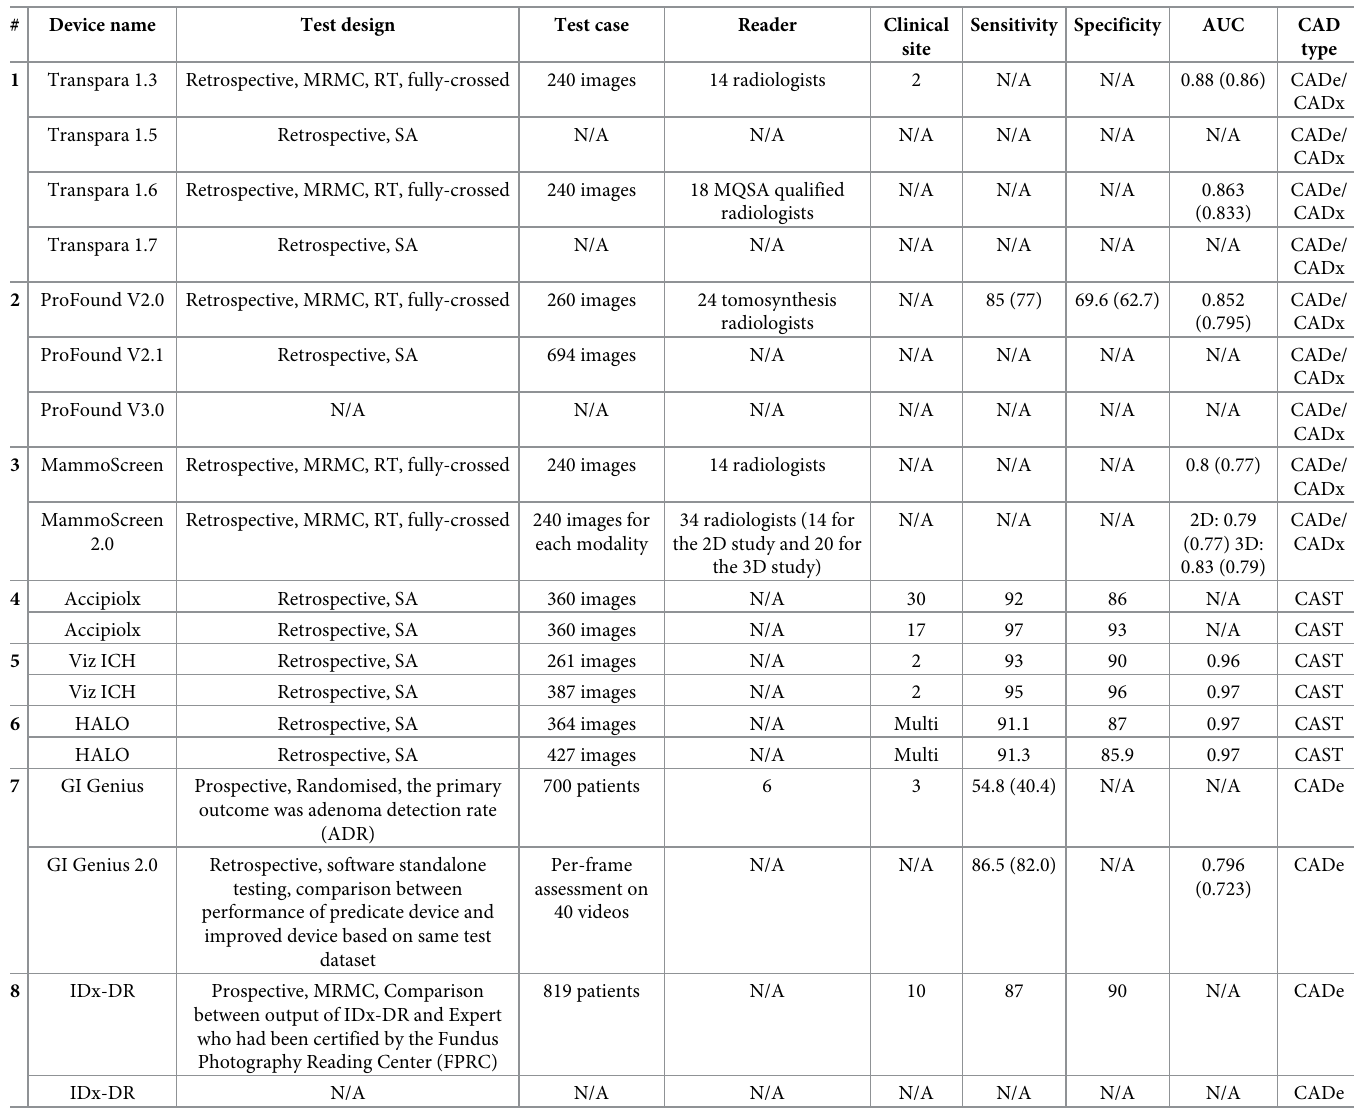
Table 2. Evaluation method of the 8 devices improved at post-market in the USA. MRMC, Multi-reader multi-case; MQSA, Mammography Quality Standards